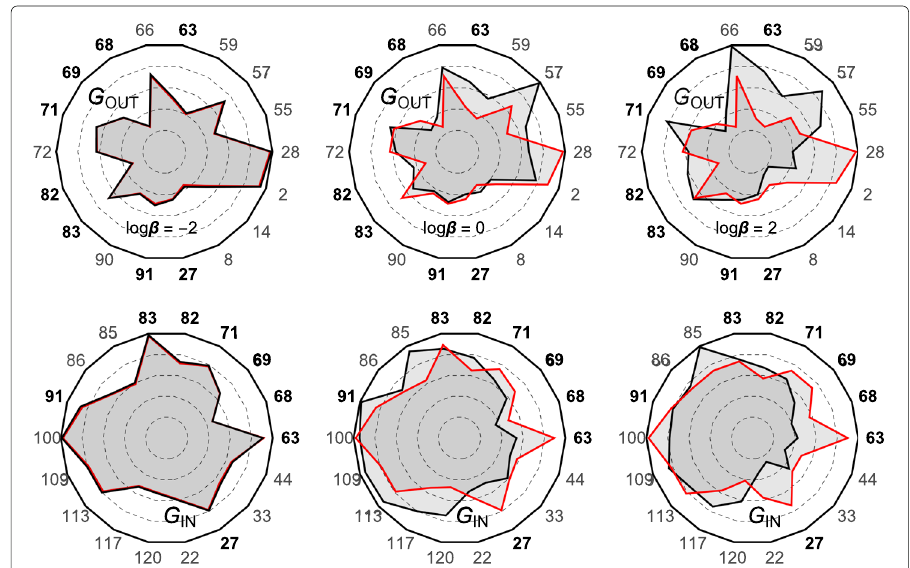
Fig. 5 Radar maps of the key concepts in the collated network. The radar map representation of the 18 most important key concepts in the collated concept network. In the left column, the communicability (black polygon) is compared with the strength of nodes (red polygon) for the weighting β = 10 − 2 . In the middle, the communicability (black) and the strenght (red) are compered for β = 10 0 , and on the right for β = 10 2 . The out- and in-communicabilities are shown in the upper and lower rows,